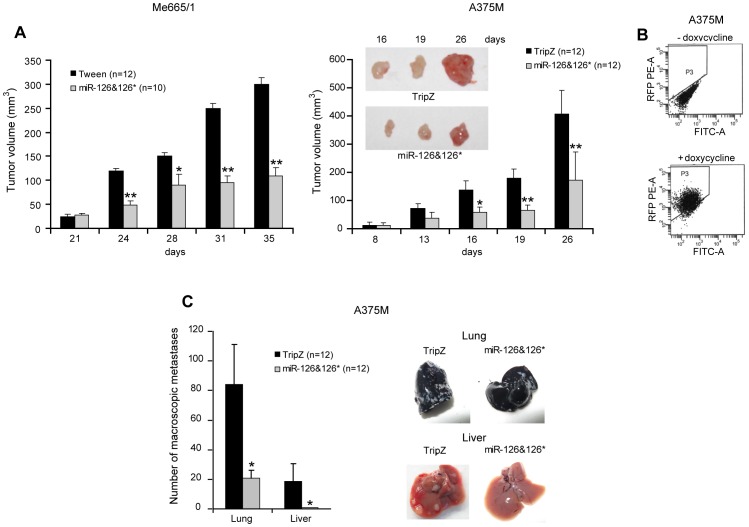
Effects of miR-126&126* overexpression in in vivo xenograft models. A)
In vivo tumor growth at different time points deriving from vector- or miR-126&126*-infected metastatic melanoma cell lines s.c. injected into athymic nude mice. Representative nodules are shown as an insert. B) Representative flow cytometer results of doxycycline-dependent induction of the RFP reporter in cells deriving from dissociated tumor nodules. C) Total number (left) and representative pictures (right) of lung and liver macroscopic metastases obtained by intravenous injection of the A375M cell lines. Columns, mean±SD of two independent experiments; **, P<0.001; *, P<0.05.